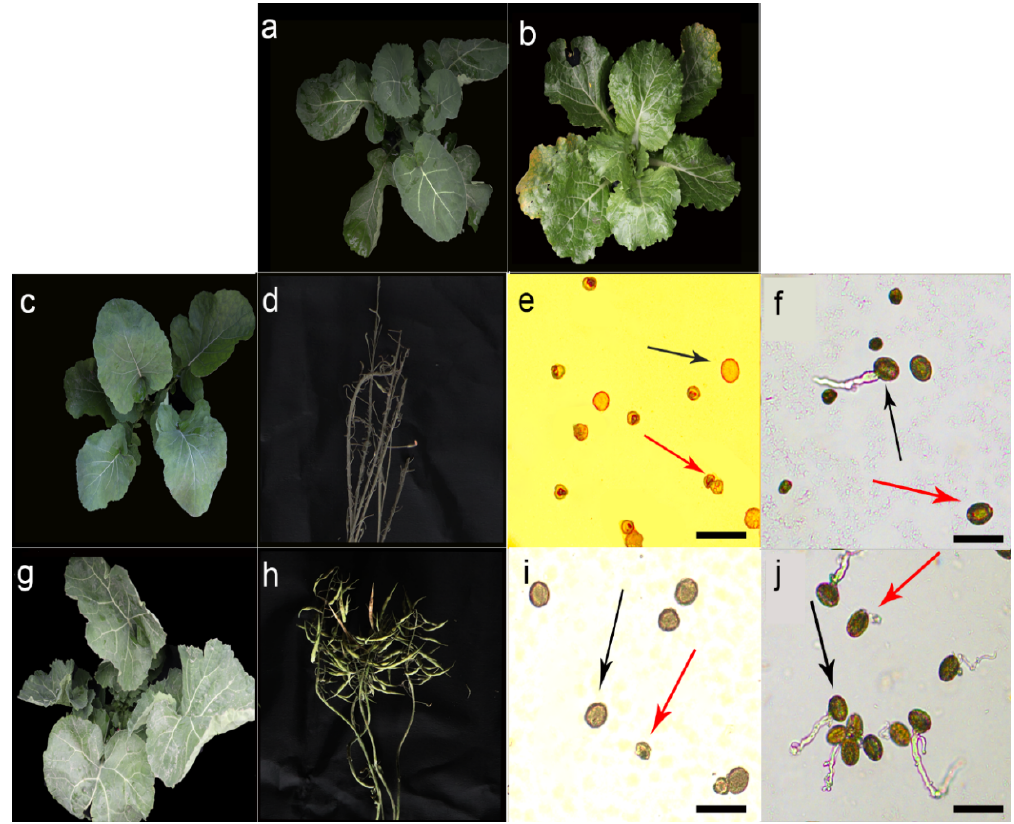
Figure 1. Phenotype observation diagram of some parent, F 1 , and induced F 1 plants: ( a ) ZS11 seedling stage morphological characteristics; ( b ) HZ32 seedling stage morphological characteristics; ( c ) T19-5 seedling stage morphological characteristics; ( d ) T19-5 mature fruit pods; ( e ) T19-5 pollen grain morphology observation, black arrows indicate fertile pollen grains, red arrows indicate sterile pollen grains; ( f ) T19-5 pollen germinates after 4 h in vitro observation, the black arrow points to the germinated pollen grains, and the red arrow points to the ungerminated pollen grains; ( g ) W59 seedling morphological characteristics; ( h ) W59 mature fruit pods; ( i ) W59-8 pollen grain morphology observation, black arrows indicate fertile pollen grains, red arrows indicate sterile pollen grains; ( j ) W59 observation of pollen tube germination 4 h after the pollen was in vitro, the black arrow points to the germinated pollen grains, and the red arrow points to the ungerminated pollen grains. Ruler = 20 µ